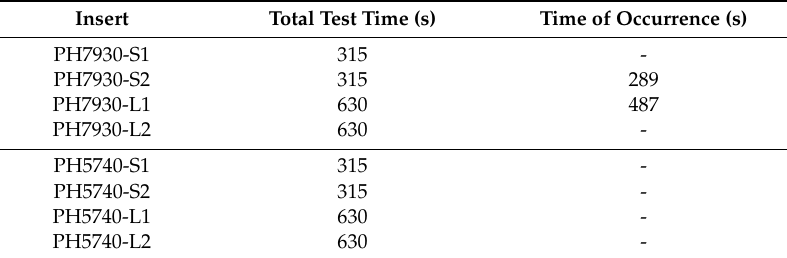
Table 12. Time of failure occurrence.